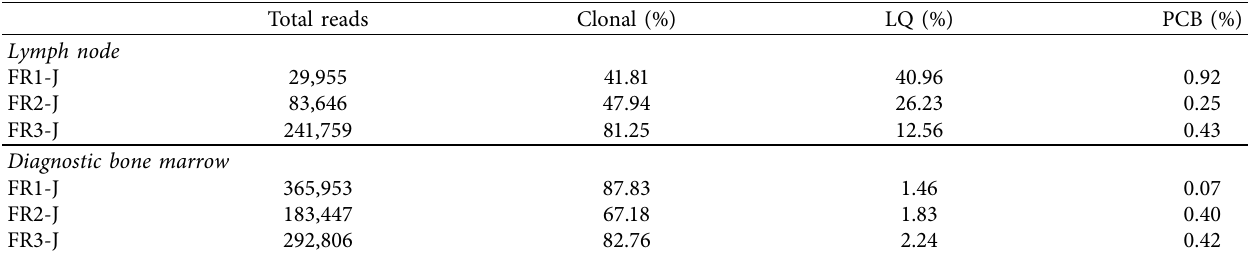
Table 1: Identification of a clonal population in the lymph node and bone